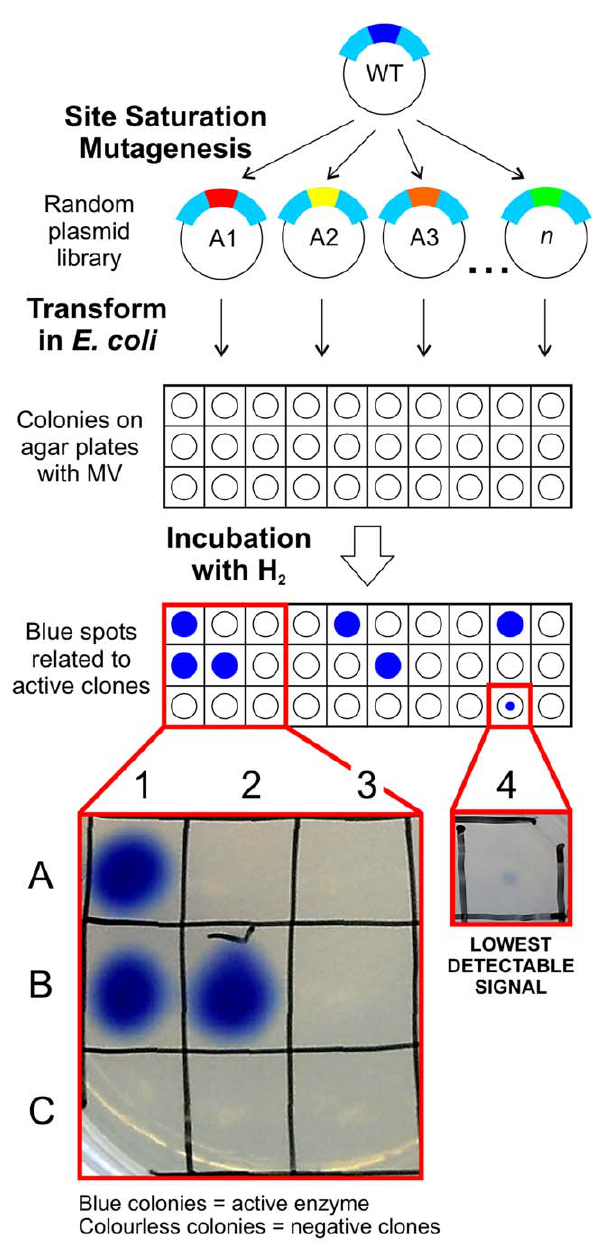
Figure 2. Scheme of C298 site saturation library screening. Each clone from the library is tested for hydrogenase activity in vivo in E. coli colonies. Only colonies expressing an active variant specifically developed a blue colour due to H 2 -driven reduction of methyl viologen (MV). Inset: Representative set of E. coli colonies used. Most clones are negative (colourless), while some (blue) show wild type -like activity (A1, B1). As positive control, a colony expressing CaHydA wild type was also plated